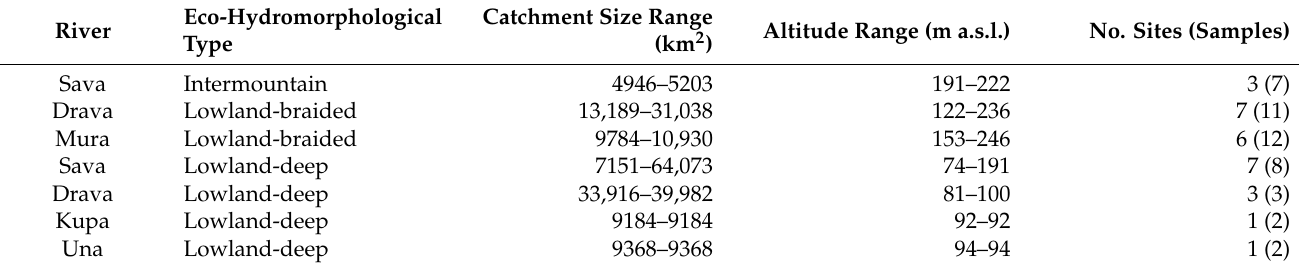
Table 1. Main characteristics of the sampled rivers according to the eco-hydromorphological river type and the number of sampling sites and